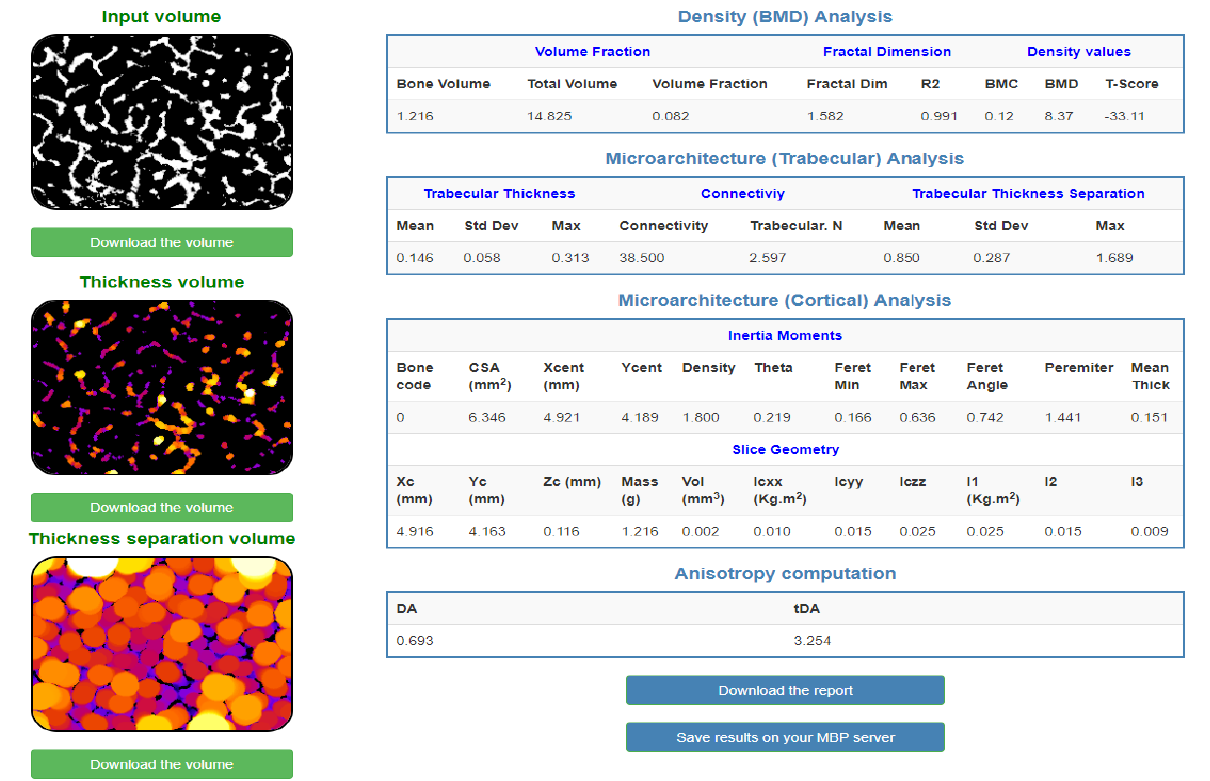
Figure 5 | Personalized version of our Cloud-based Computer Aided Diagnosis for